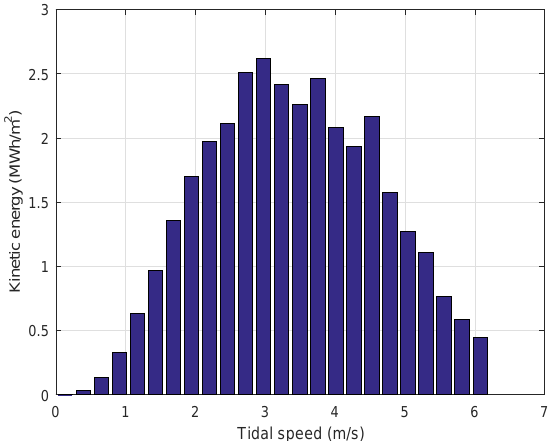
Figure 7. Tidal current energy distribution.